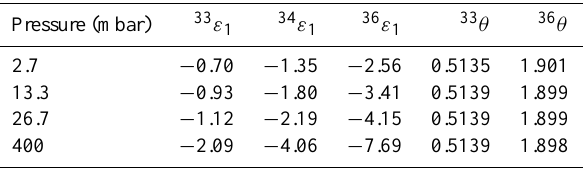
Table 3. Isotope effects for OCS photolysis by Xe lamp as a func- tion of OCS pressure estimated from the ZPE-shift